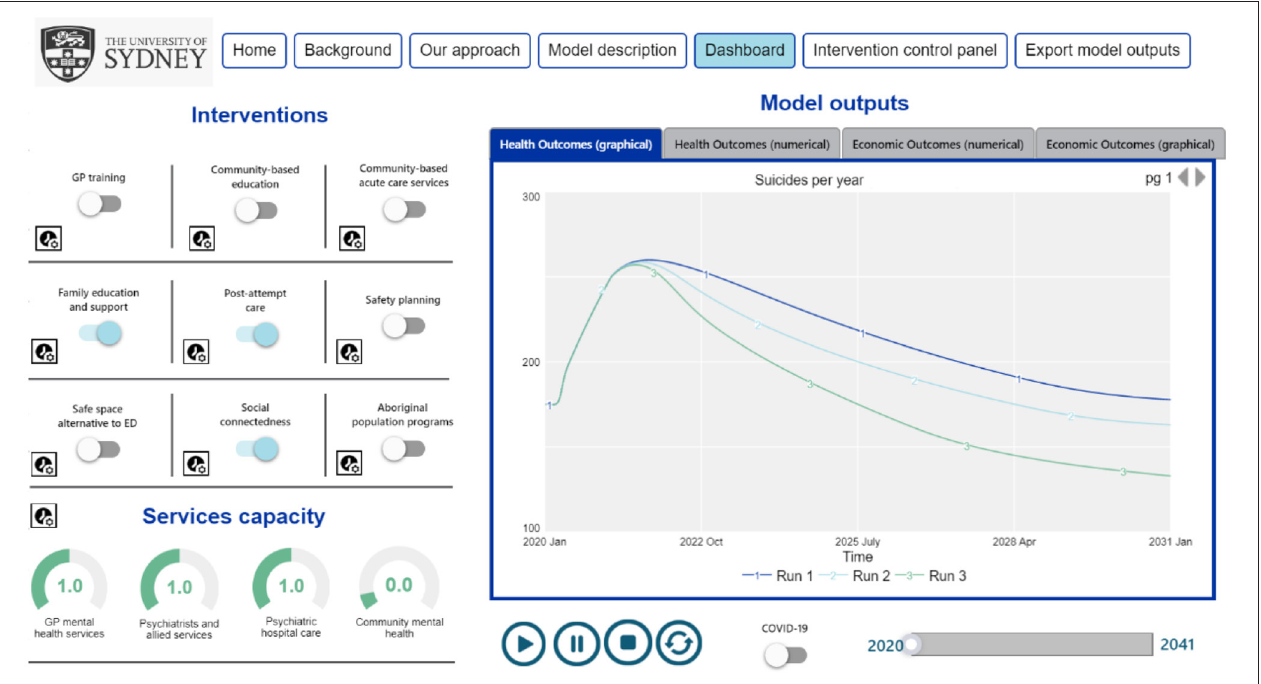
FIGURE 2 | An example interactive interface demonstrating how stakeholders can engage with systems models as decision support tools; simulating the likely impacts of policies and initiatives before investing in